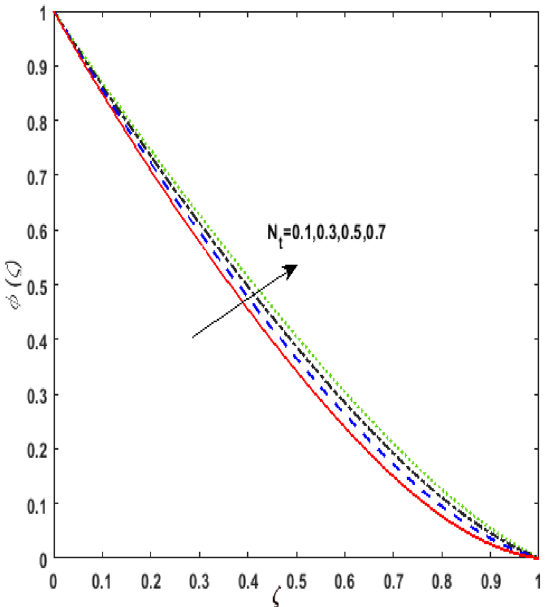
Figure 15. Effect of thermophoresis parameter N t on concentration φ(ζ) .